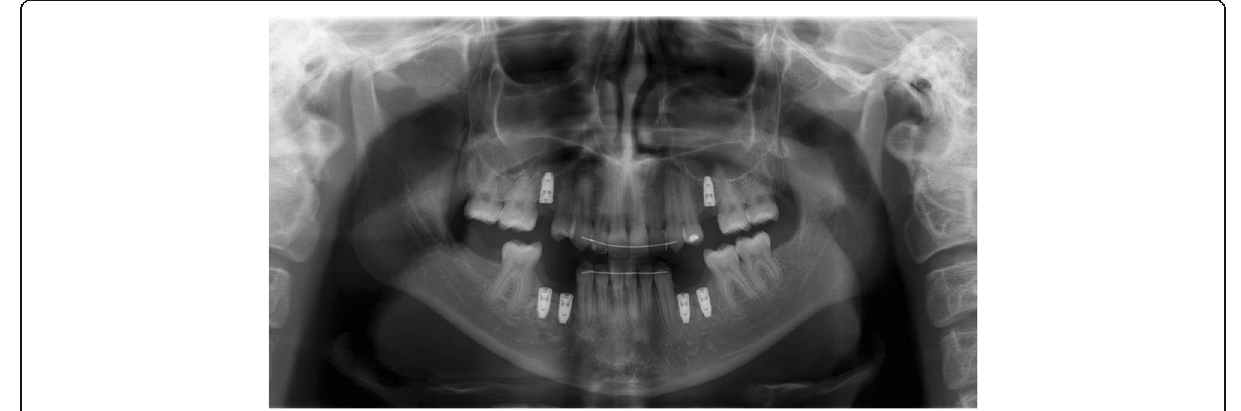
Fig. 6 Patient 1 — post-operative orthopantomogram (OPT) at age of 18